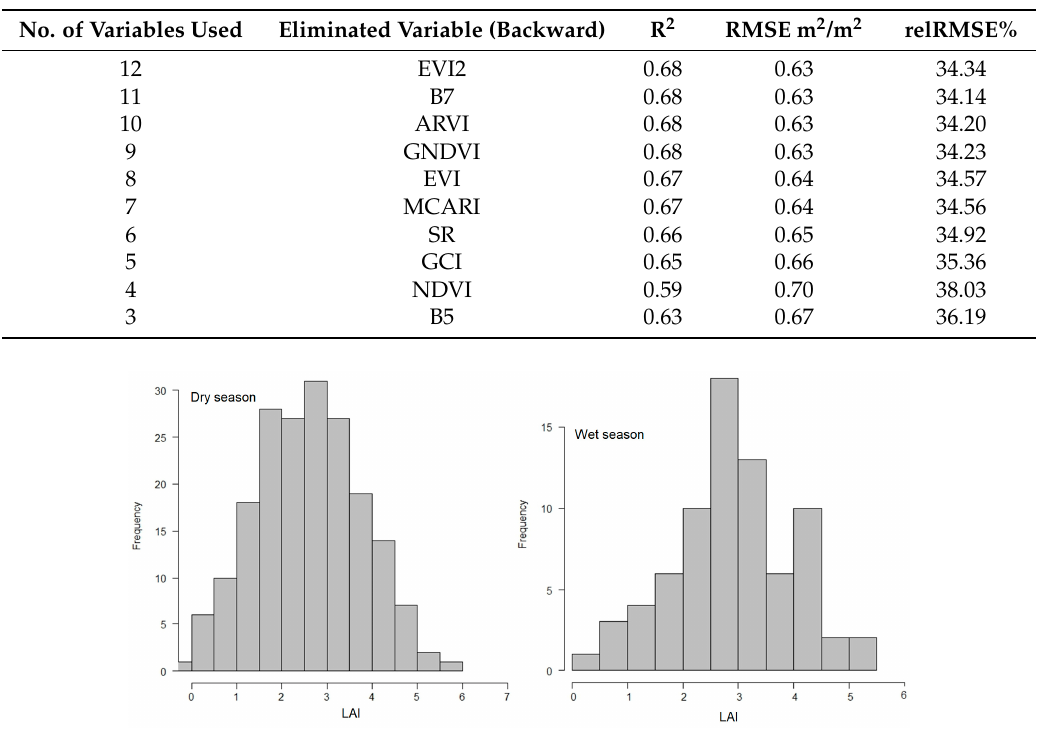
Figure 4. Histogram for predicted LAI for dry season and wet seasons.